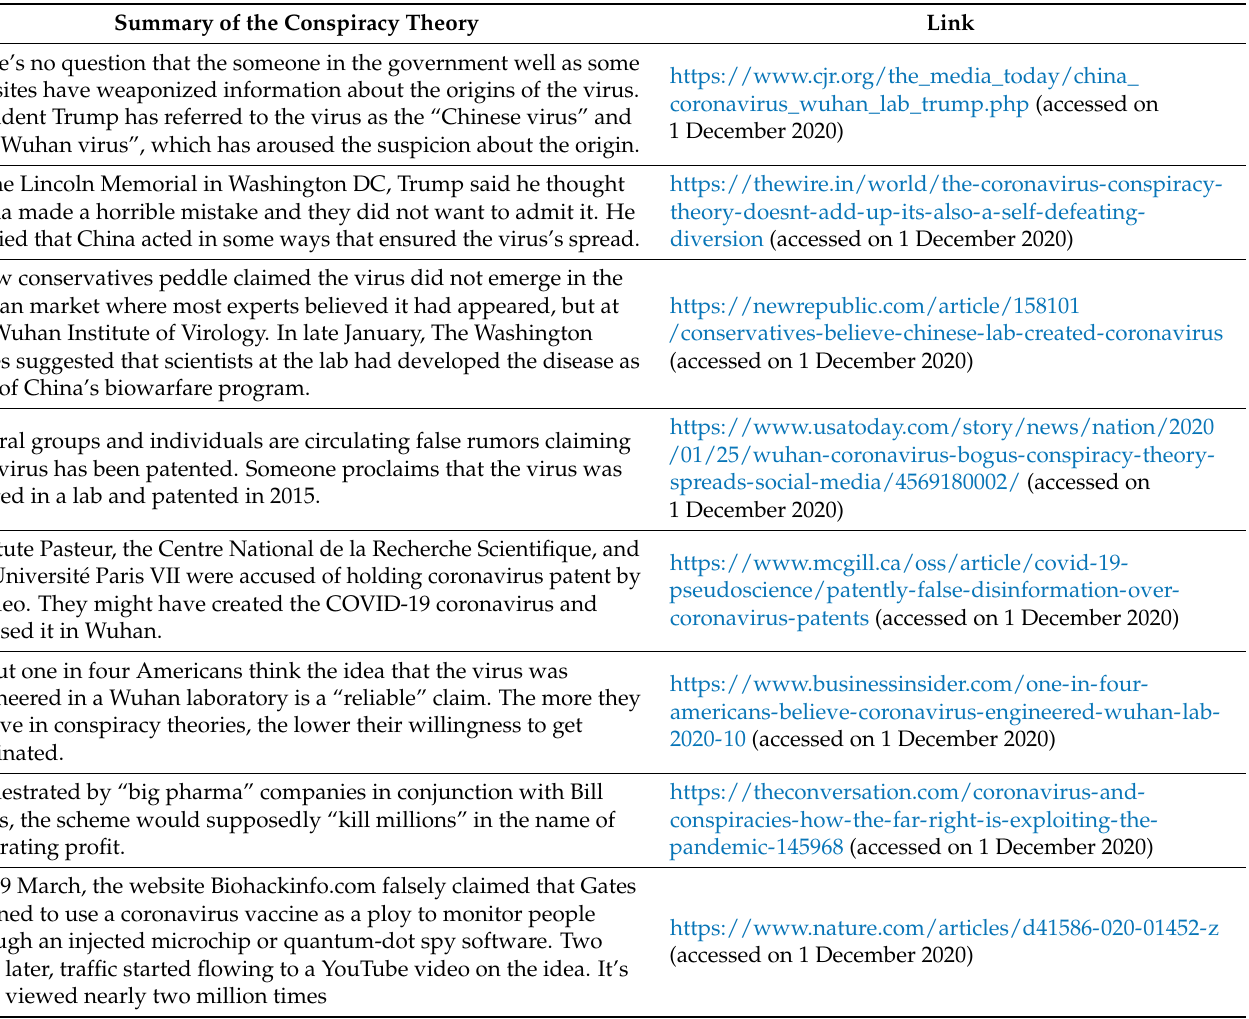
Table A1. Popular coronavirus disease 2019 (COVID-19) conspiracy theories on the